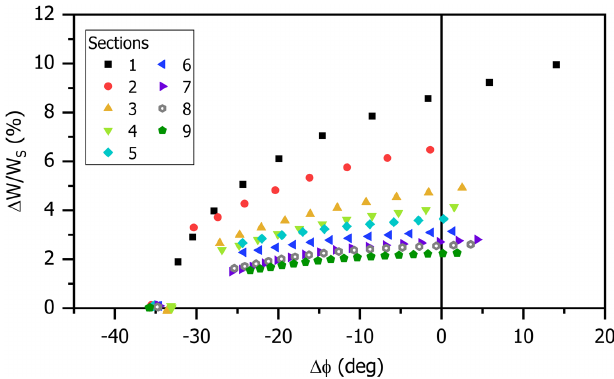
FIG. 20. Bunch center motion along the whole 65 MV proton linac.